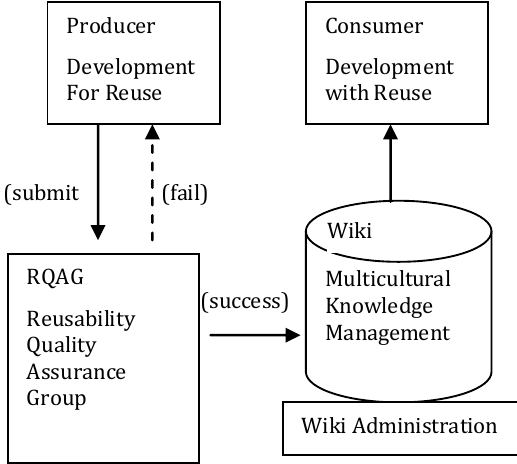
Figure XVII : The reusability model of our